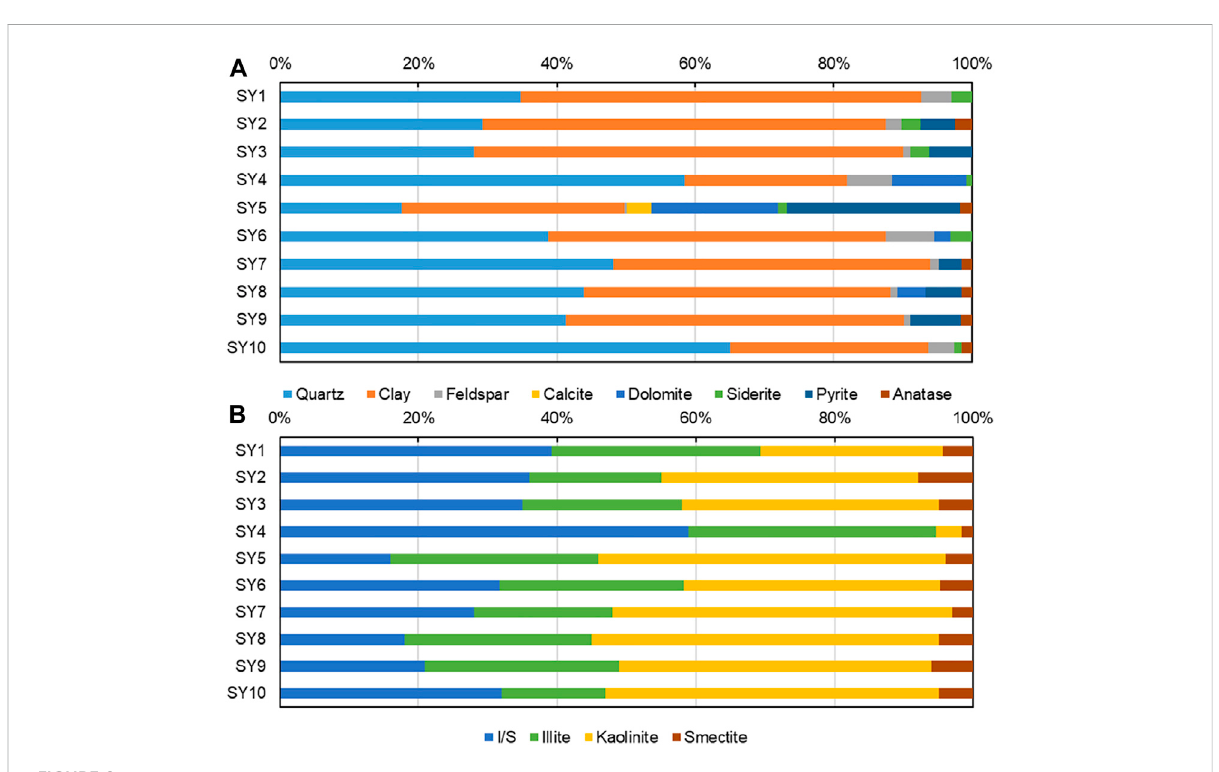
FIGURE 2 Major mineral (A) and clay mineral (B) composition of shale